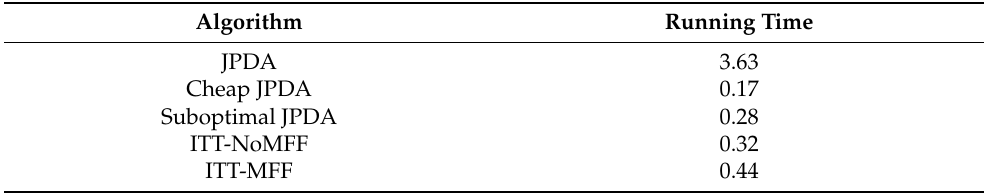
Table 7. Running time comparison (Unit: